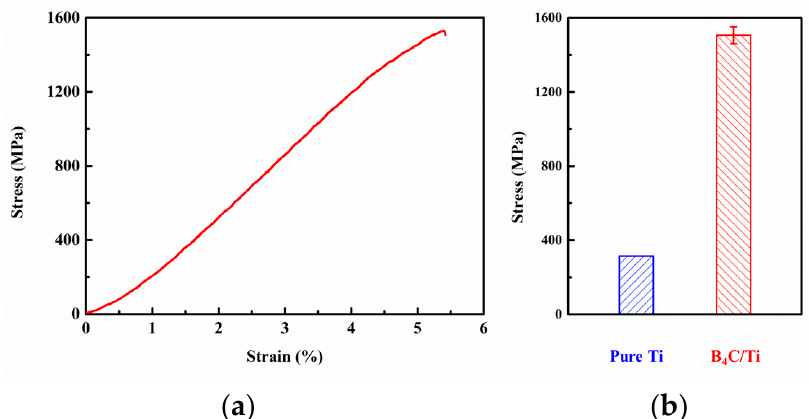
Figure 9. Compressive mechanical properties of composites with core-shell structure; ( a ) strain– stress curves; ( b ) comparison of mechanical properties (the yield strength of pure Ti is obtained from Ref. [26]).